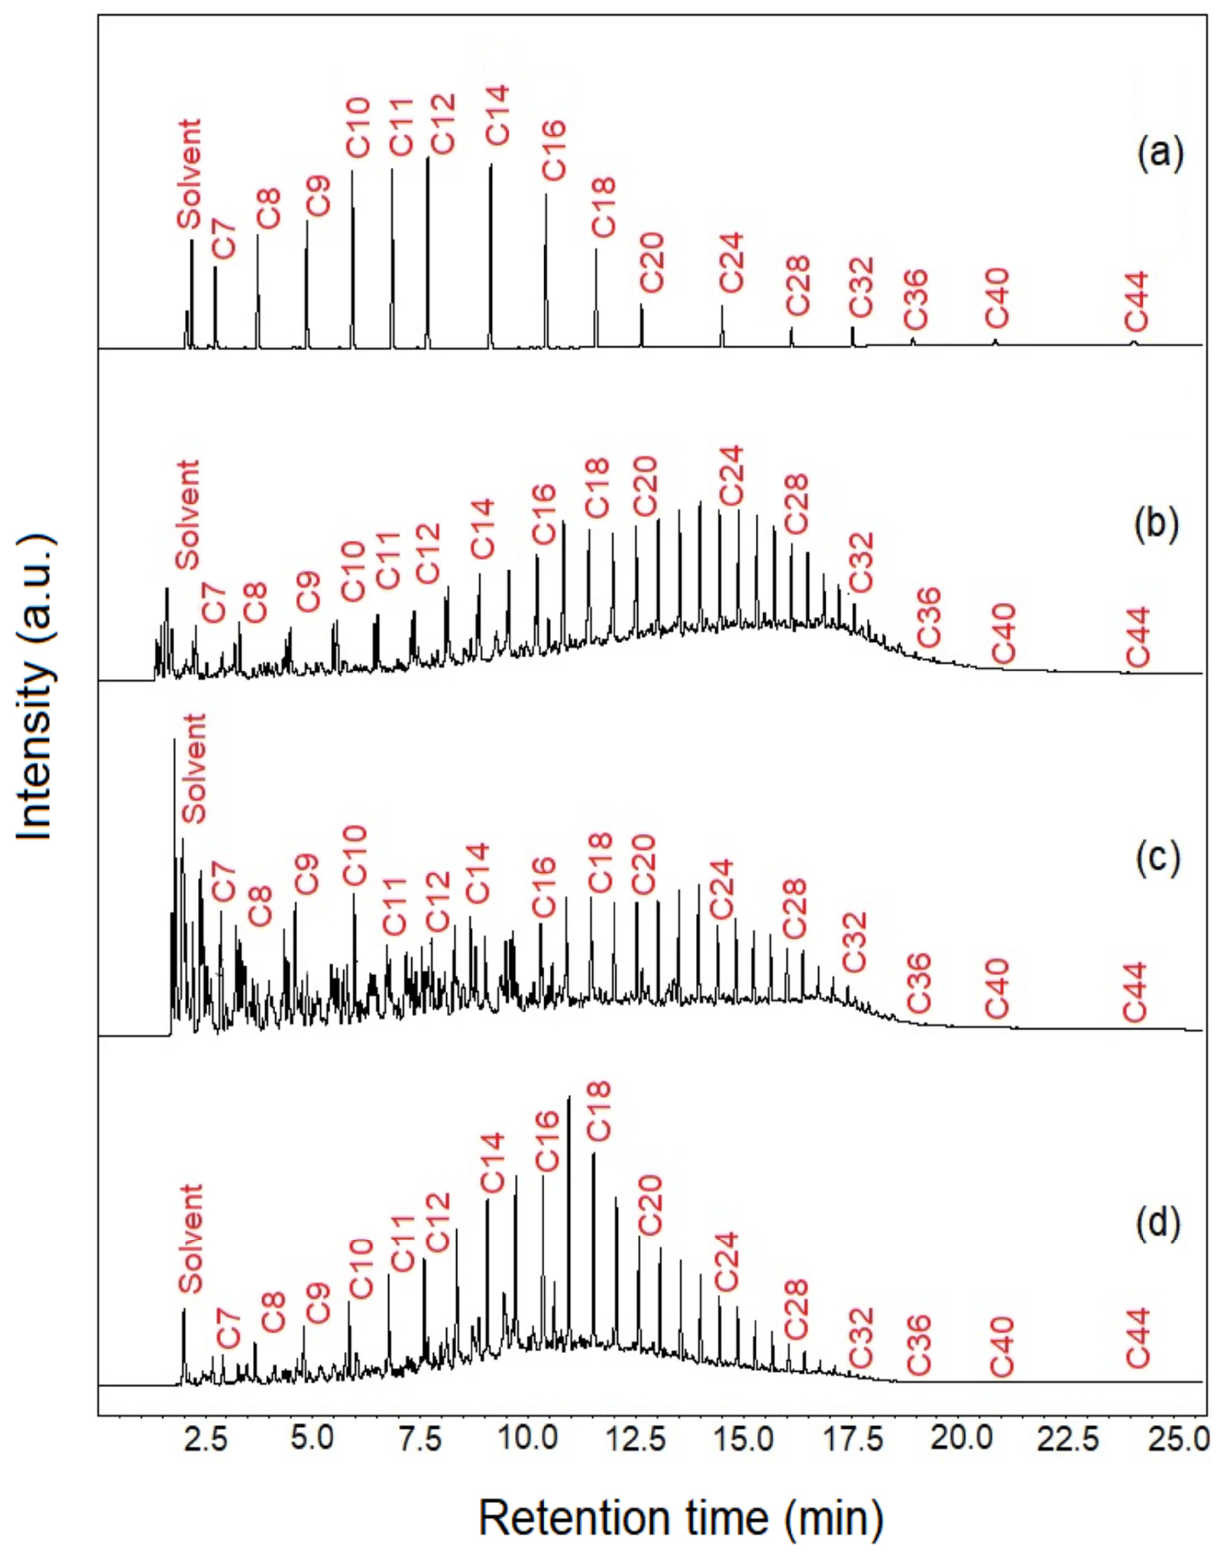
Figure 4. Chromatograms of hydrocarbons from: ( a ) Supelco standand for C 7 -C 44 hydrocarbons; ( b ) distilled products from ATR; and ( c ) distilled products from HY/ATR and ( d ) HY-MCM-41/ATR. By evaluating the chromatograms, a wide range of hydrocarbons is verified in the ATR, mainly between C 10 and C 32 . For the HY/ATR sample distillate, a greater number of peaks were identified in the first 7 min of retention time. This period corresponds to the elution of the components in the gasoline range, due to the acidity of the protonated zeolite associated with the presence of micropores in the zeolite HY. From this time on, no major changes were observed in relation to the pure ATR. However, when the HY- MCM-41 hybrid catalyst was used, the formation of hydrocarbon fractions in the C 11 -C 12